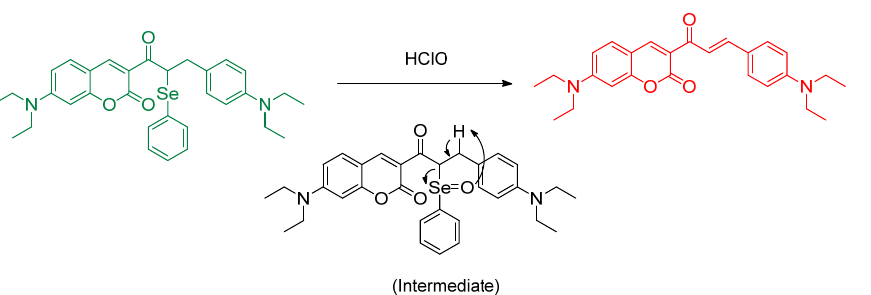
Figure 20. Coum–Se chemosensor for HOCl probe reported by Xie et al.